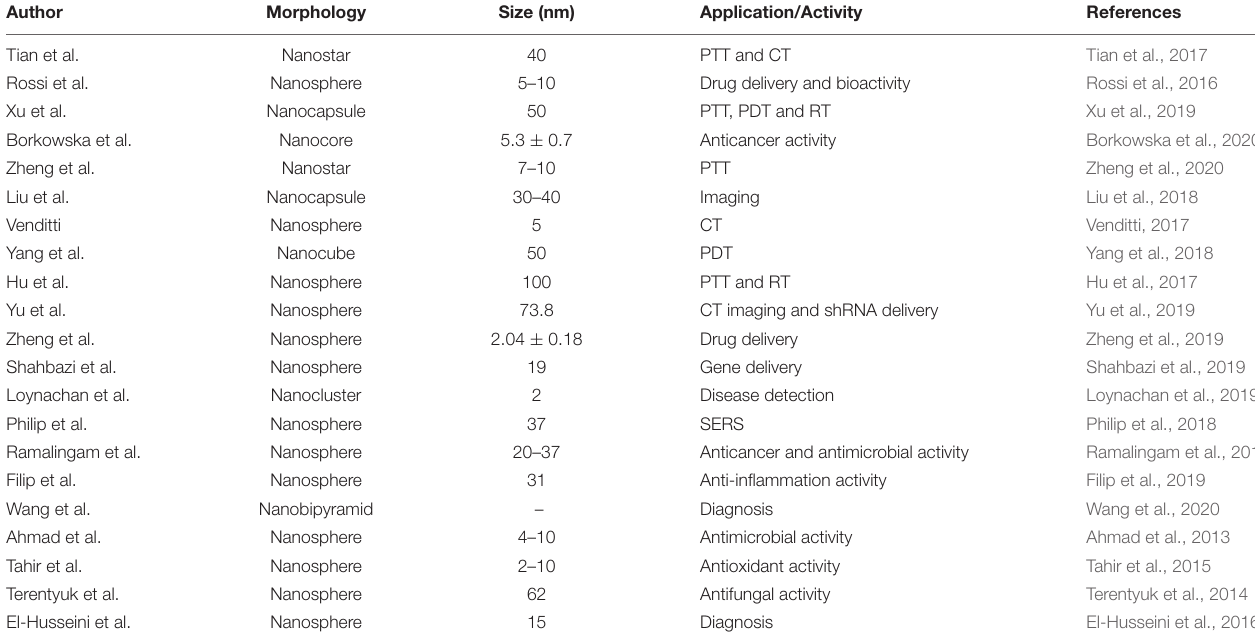
FIGURE 8 | A schematic representation of medical applications for AuNPs. TABLE 5 | The application or activity of AuNPs with different morphology and